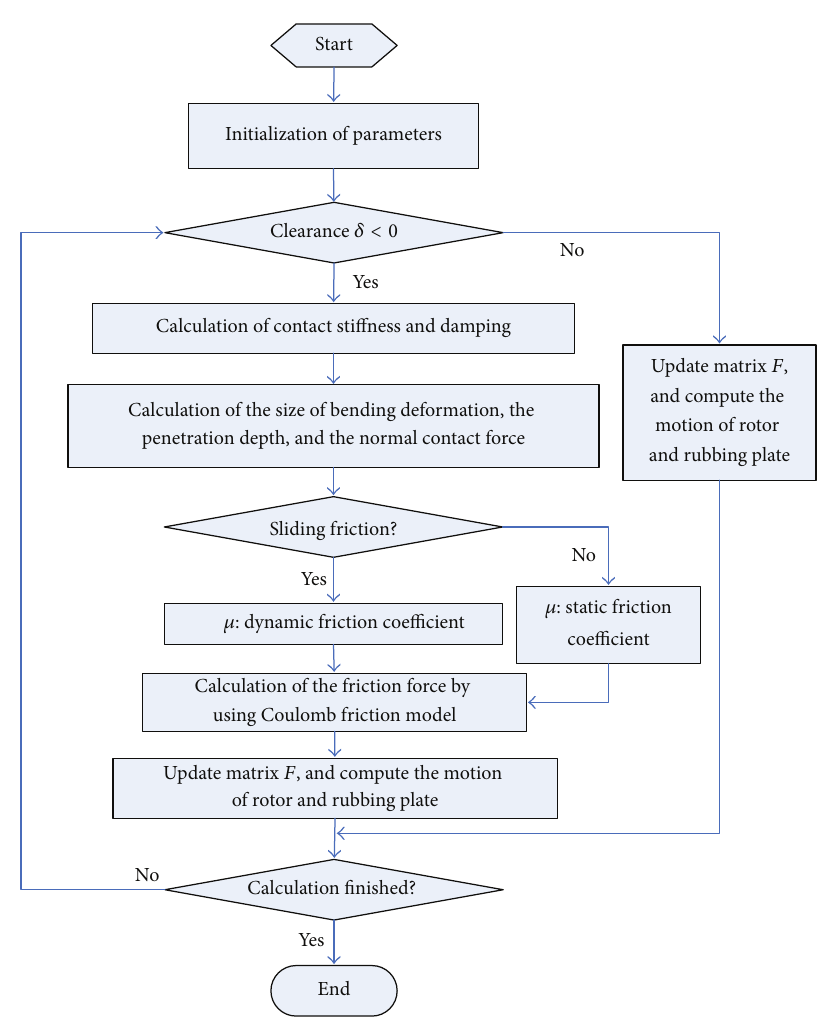
Figure 5: The simulation flow chart of dual-rotor system with rub-impact fault.